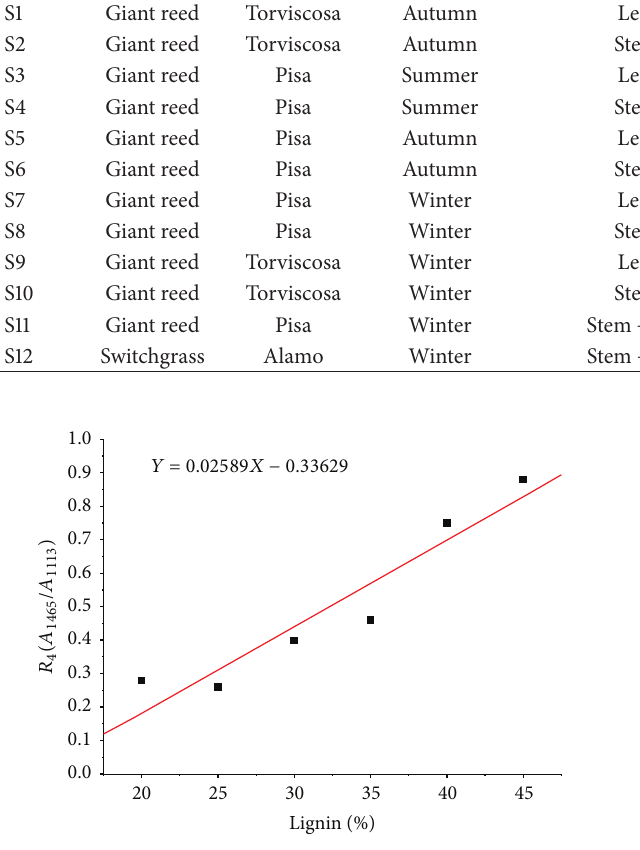
Figure3:Predictivemodelforthedeterminationoflignininternary mixtures of